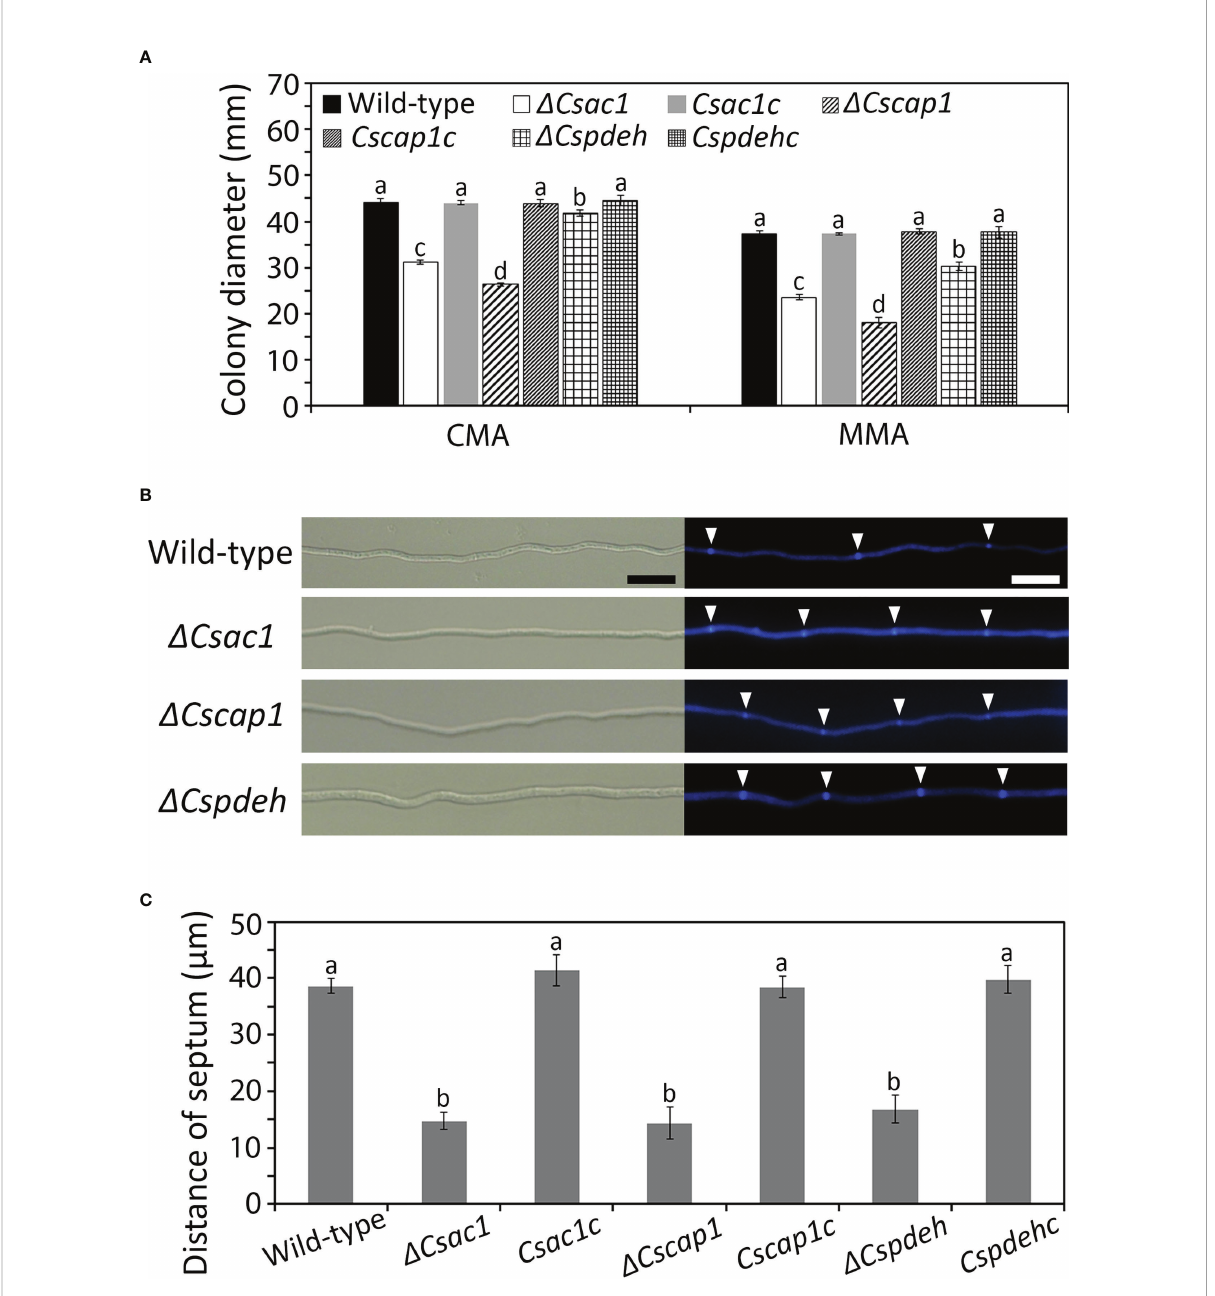
FIGURE 3 Roles of CsAc1 , CsCap1 , and CsPdeH in vegetative growth. (A) Quantitative measurement of mycelial growth. Mycelial agar plugs (5 mm diameter) from 4-day-old MMA were inoculated onto CMA and MMA and incubated at 25°C without light. Colony diameters were measured after 5 days. (B, C) Increased septation during vegetative growth of D Csac1 , D Cscap1 , D Cspdeh . (B) Septa in mycelia at 24hours post-inoculation on CMA with calco fl uor white staining. Scale bar, 20 m m. (C) Septum distance measured using ZEN imaging software. For each strain, 50 hyphal compartments were measured. Error bars show standard deviations and different letters in the same group indicate signi fi cant differences estimated using Duncan ’ s test (P <